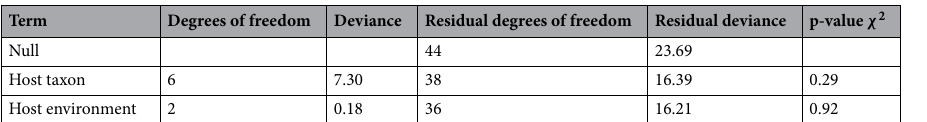
Table 3. Analysis of deviance for GLM (Richness microbiome functional alpha